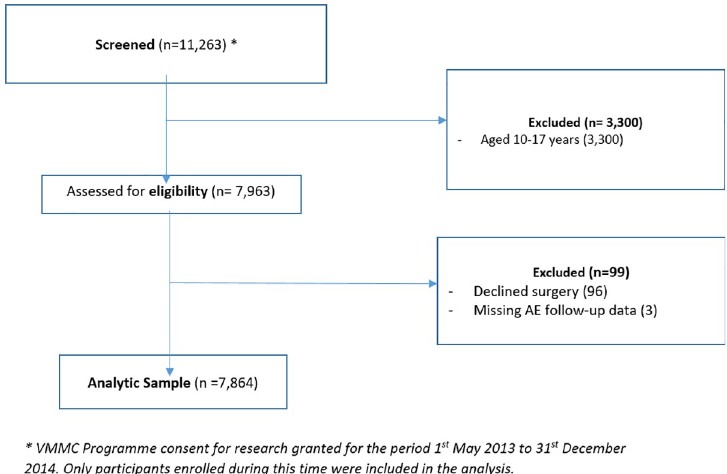
Fig 1. Flow of participants through the voluntary medical male circumcision (VMMC) programme among adult men in Gauteng and North West provinces of South Africa between 01 May 2013 and 31 December 2014.